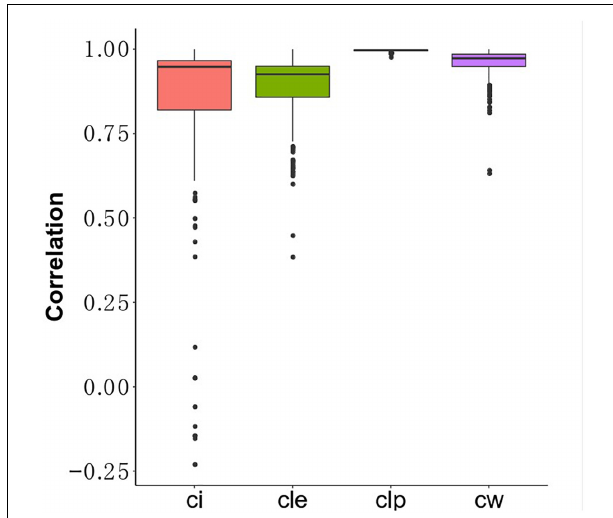
FIGURE 6 | The distribution of Pearson value of fractions between drugs and